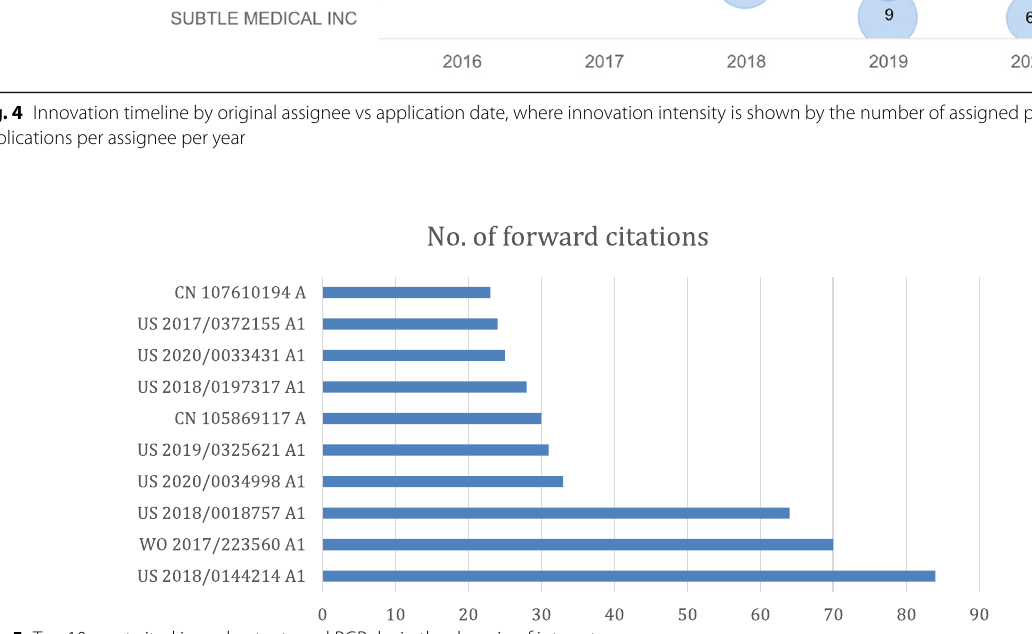
Fig. 5 Top 10 most cited issued patents and PGPubs in the domain of